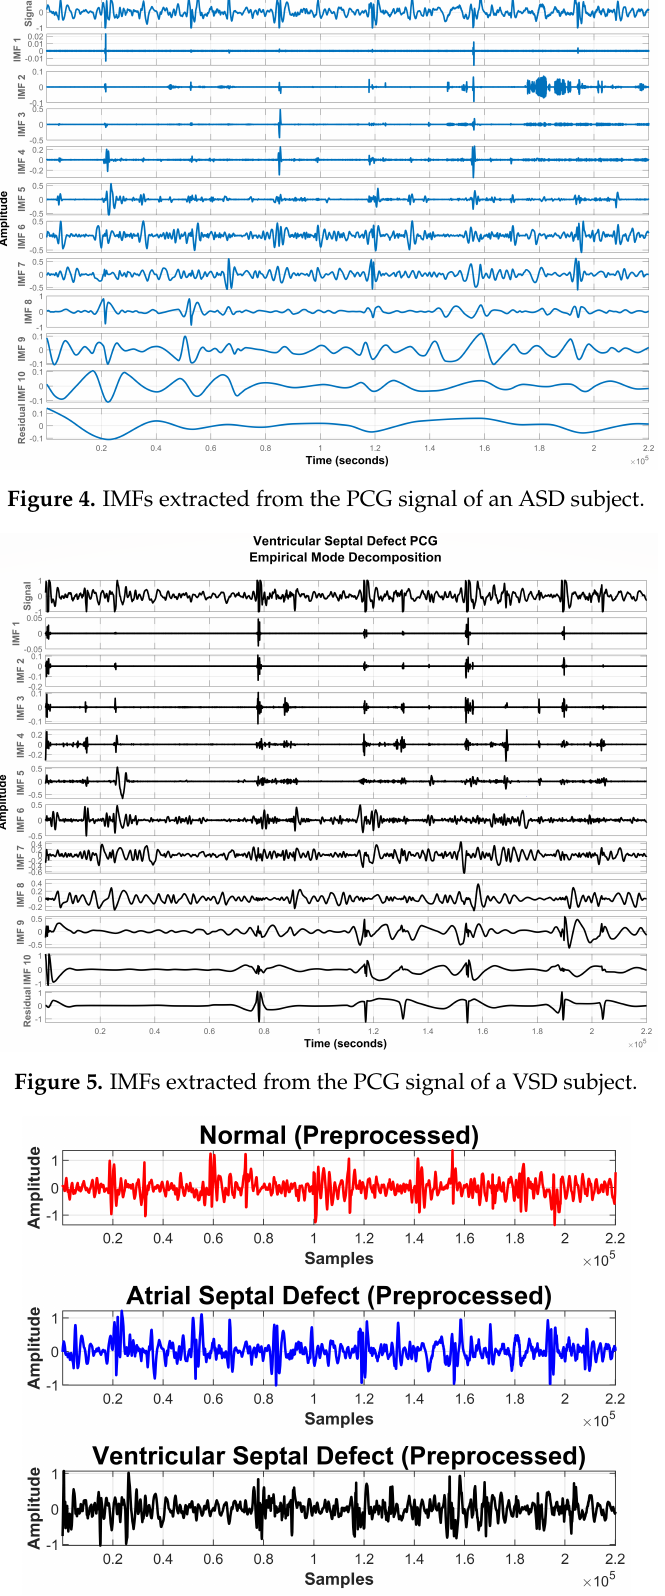
Figure 6. Preprocessed PCG signal of normal, ASD, and VSD